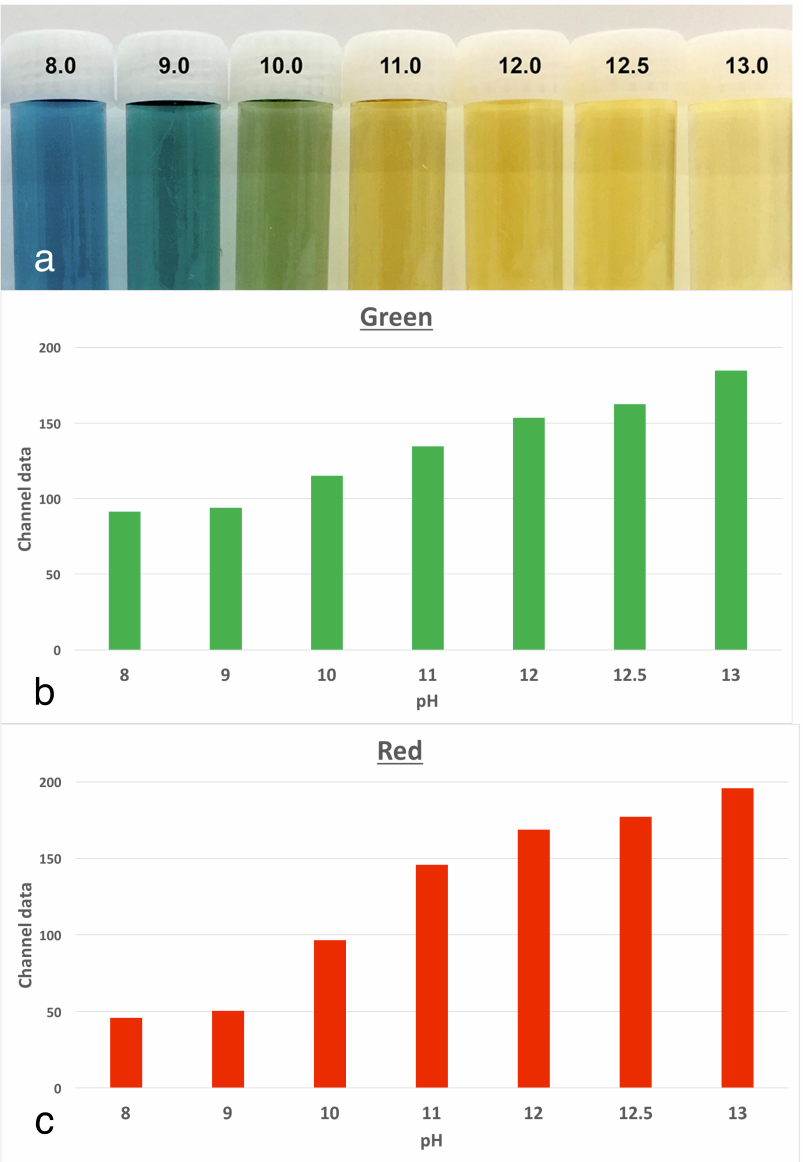
Figure 1. The colour changes in anthocyanin dye according to pH, using a series of buffers with the pH values from 8 to 13. Panel ( A ) shows the visual appearance of a solution of anthocyanin dye as the pH alters. Each vial has the same concentration of dye. Panels ( B , C ) show the digital pixel data for the pH standards of the red channel ( B ) and green channel ( C ). There is a consistent increase in both parameters as the pH rises.